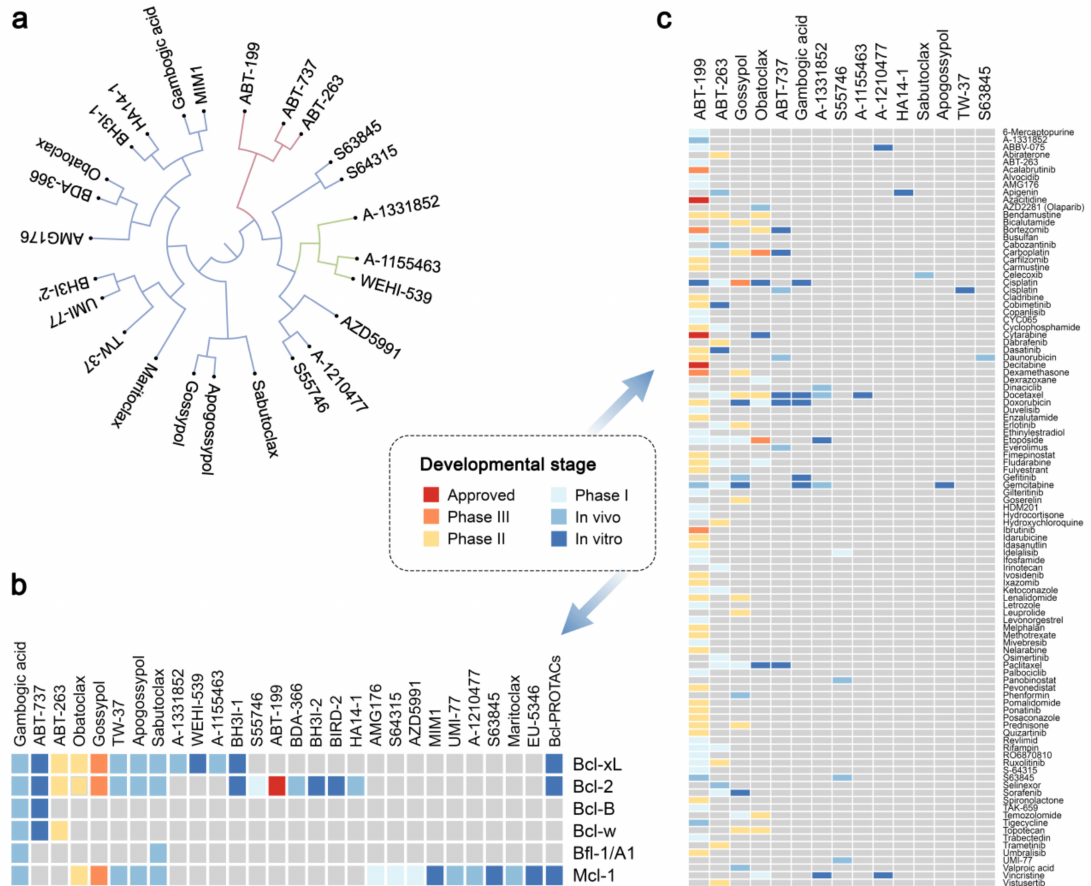
Figure 1. Bcl-2 protein family members and their combinations with other anticancer drugs. ( a ) Analysis of structural similarities between inhibitors of Bcl-2 proteins using C-SPADE. ( b ) Literature analysis of targets for inhibitors of Bcl-2 proteins. ( c ) Developmental status of drug combinations containing Bcl-2 inhibitors. For more information, please visit